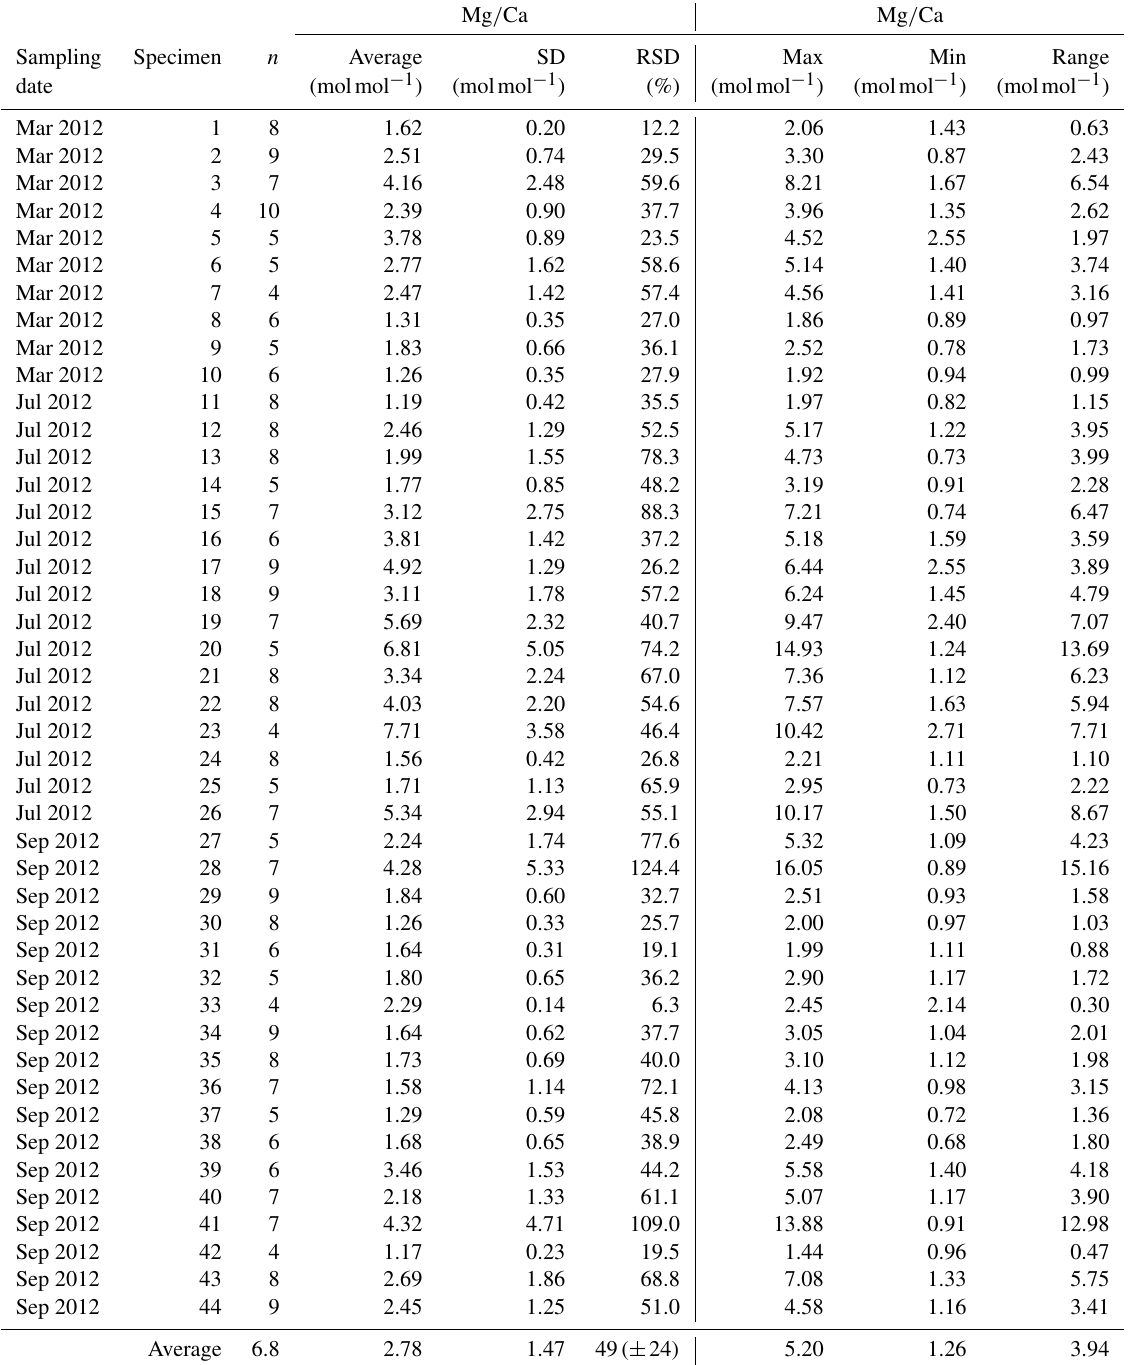
Table A2. Results of Mg / Ca measurements for different samplings of living specimens of A. tepida from Lake Grevelingen, station ST2. All data are normalized to USGS MACS-3. Values are calculated per specimen (numbers of specimens according to Fig. 2). The total number of chambers included is indicated in column “ n ”. Calculations were performed using all